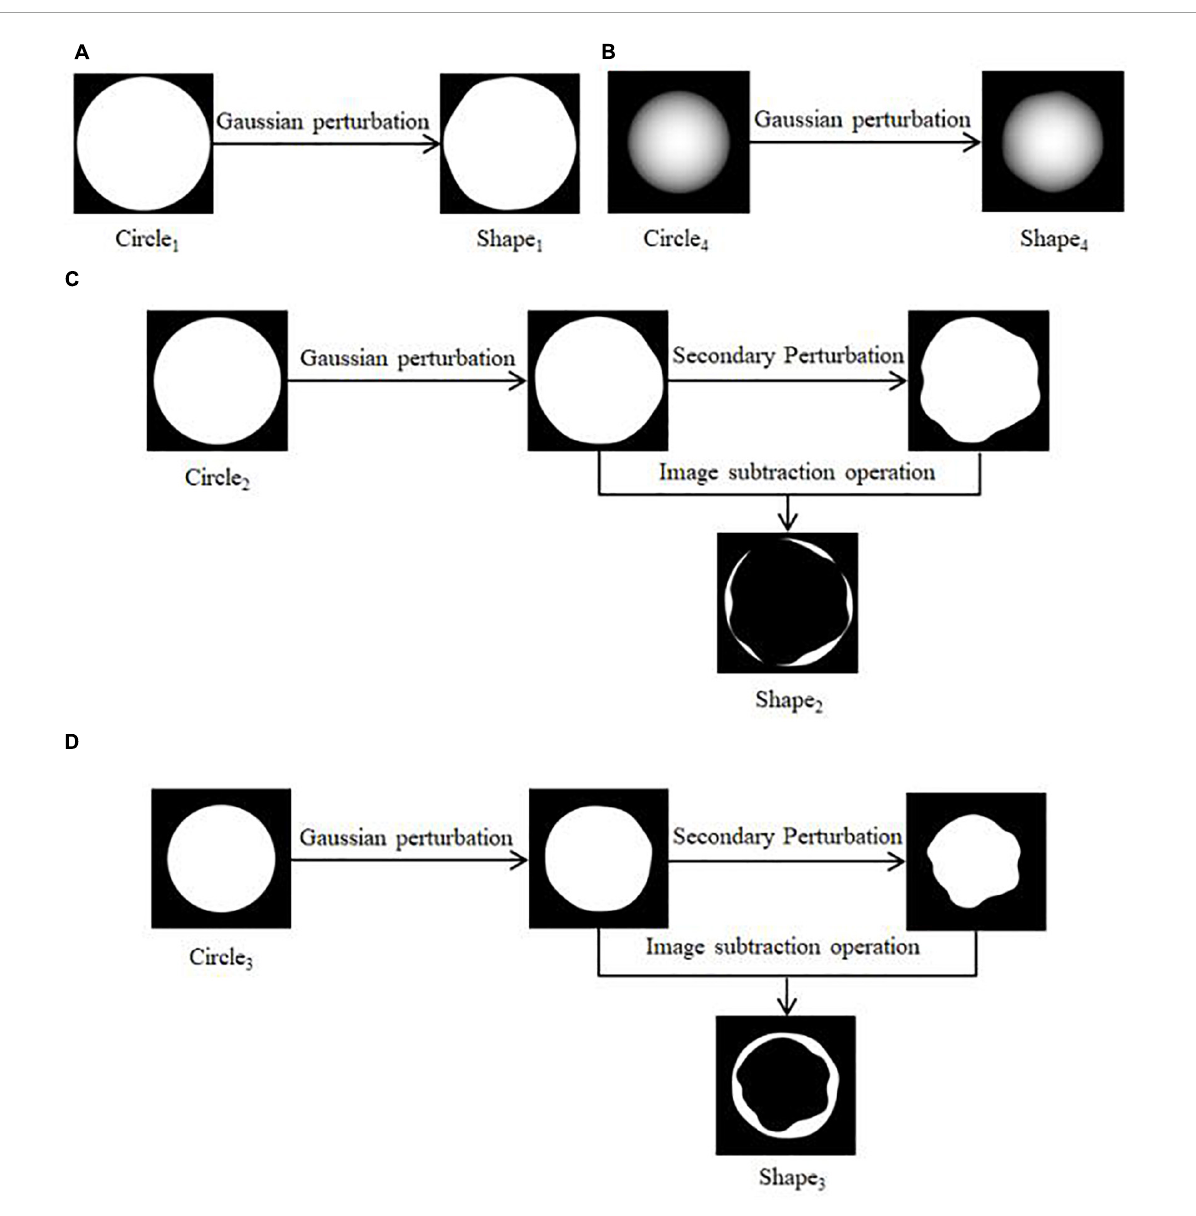
FIGURE3 Pre-processing of shapes. (A) Generation of Shape 1 , (B) generation of Shape 4 , (C) generation of Shape 2 , (D) generation of Shape 3